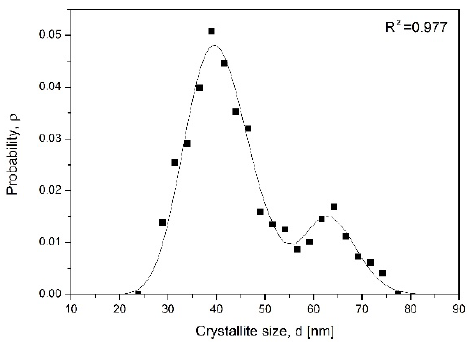
Figure 4. αFe crystallite size distribution in its nitriding process to γ′ Fe 4 N.